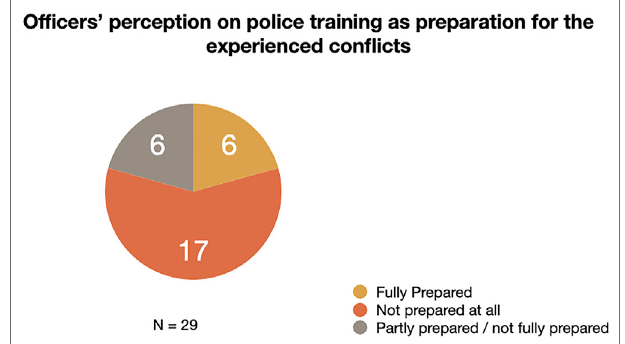
FIGURE 2 | Police of fi cers ’ perception on whether police training had prepared them for the con fl icts they had